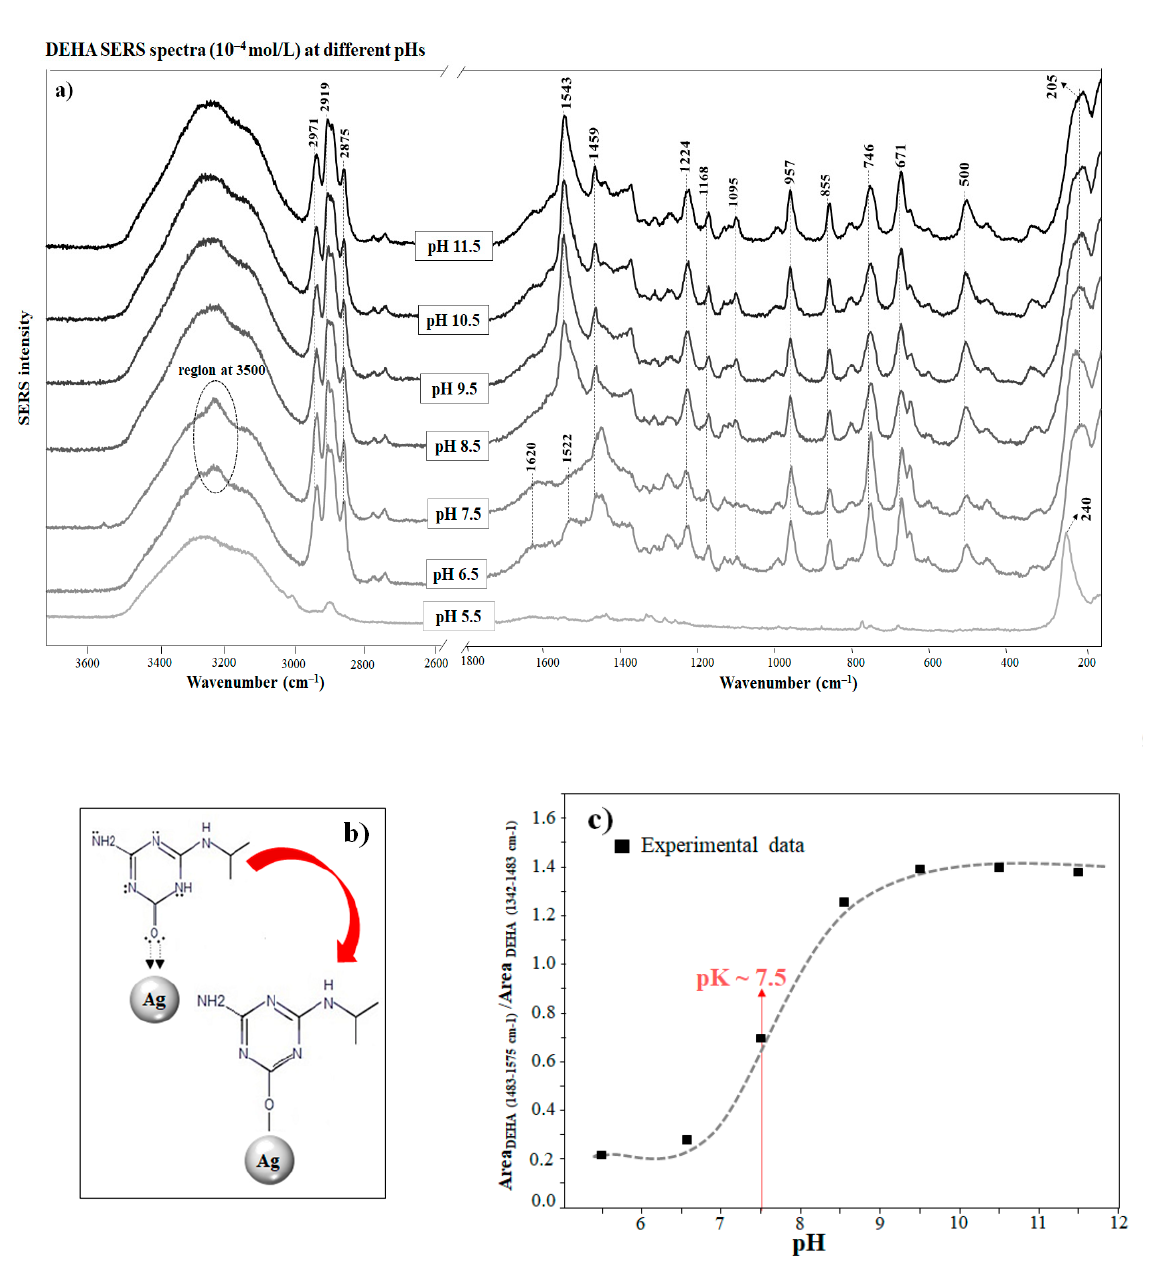
Figure 2. ( a ) DEHA SERS spectra (10 − 4 mol/L) obtained at different pHs (the spectra are normalized separately). ( b ) Ad- sorption mechanism on the silver surface in the keto and enol form. ( c ) Variation of the integrated areas of band at different